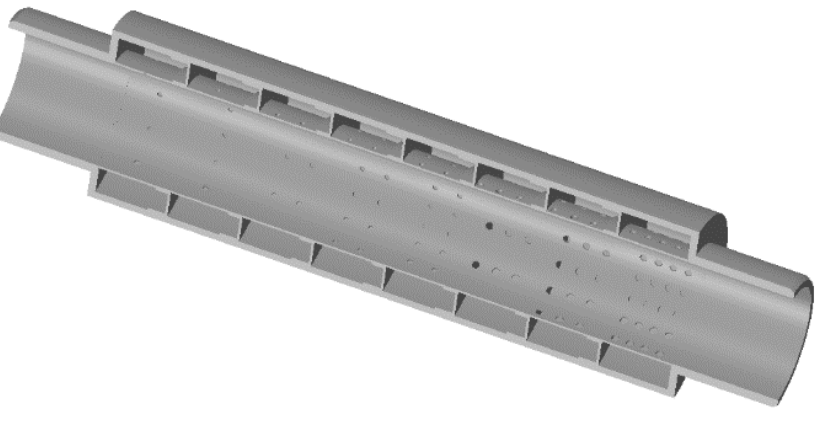
Figure 23. Schematic diagram of the perforated muffler.